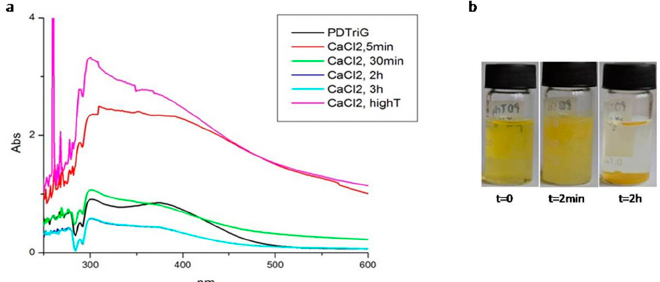
Figure 6. ( a ) UV–vis spectra of PDTriG (pH = 10, 0.5 mg/mL) on addition of CaCl 2 (1:1 equivalents) in basic media at 25 ◦ C after 5 min (red), after 30 min (green), after 2 h (blue), after 3 h (light blue), and at 60 ◦ C (purple); ( b ) visual observation of complexation within time demonstrating the phase separation